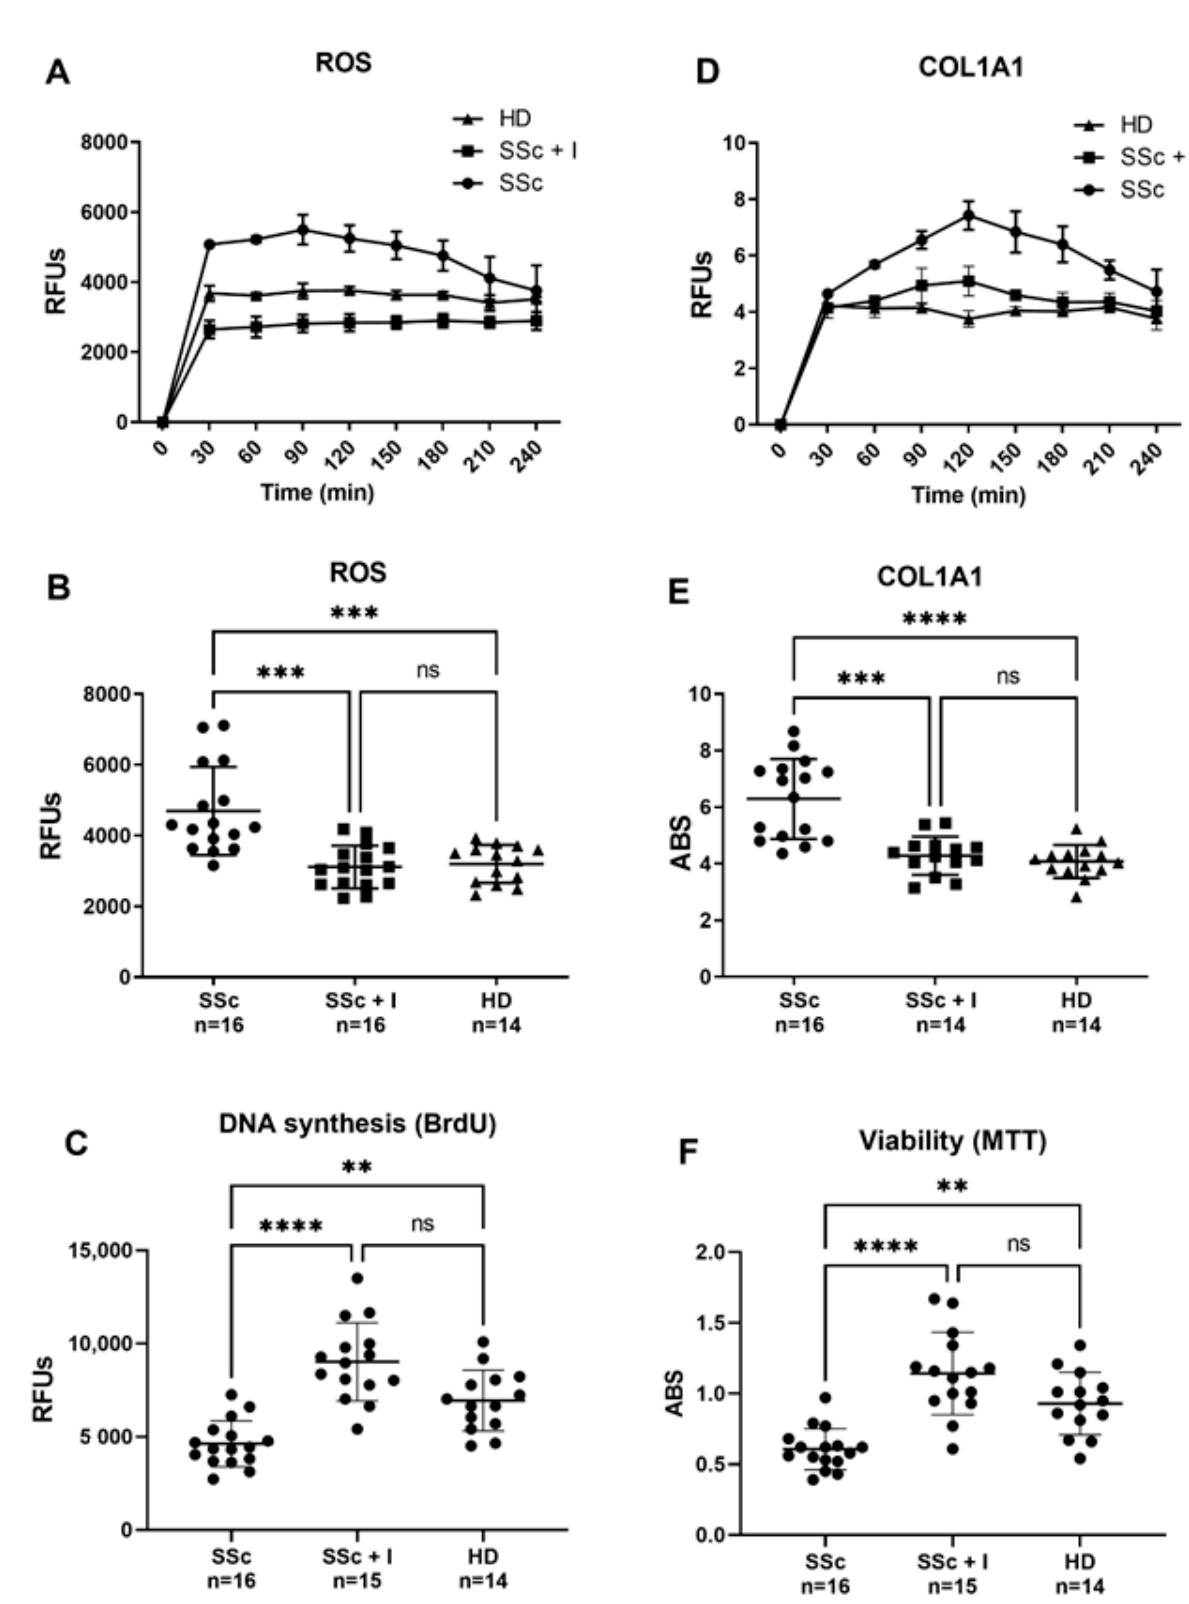
Figure 1. ( A , B ) Effect of SSc and SSc iloprost-treated sera on human pulmonary microvascular endothelial cells (HPMECs) intracellular ROS levels. Before sera treatment, subconfluent HPMECs were loaded with 10 μ M of H 2 -DCFDA, and then cultured in basal medium containing 10% ( v / v ) of sera from SSc patients (SSc), sera from iloprost-treated SSc patients (SSc + I), and sera from healthy donors (HD). Variations in intracellular ROS levels were kinetically determined in a 4 h time- course ( A ) and values at the first hour were used for comparison ( B ). Fluorescence data were normalized for protein